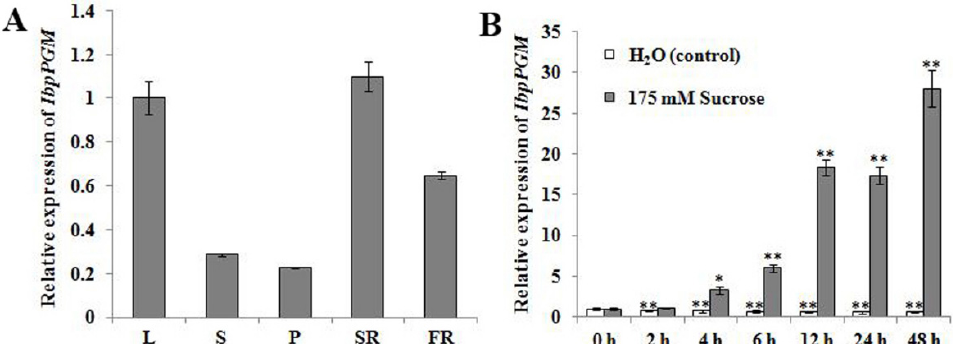
Figure 3. Expression patterns of IbpPGM. ( a ) Expression of IbpPGM in different tissues of Xu